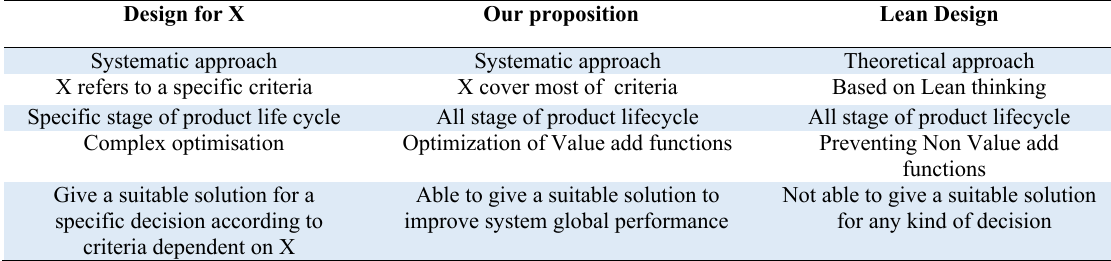
Table 2. Our proposition in comparison with existing methods Design for X